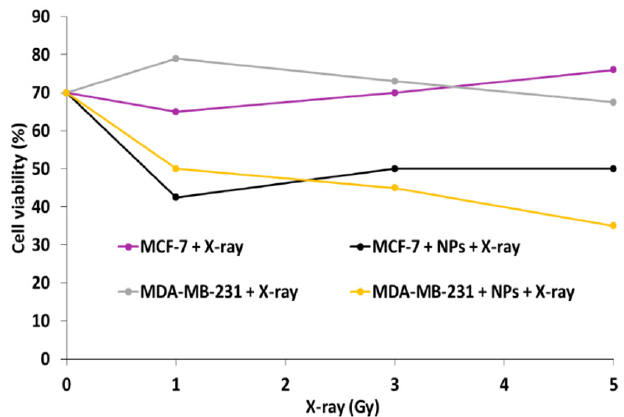
Figure 38. MDA-MB-231 and MCF-7 cells incubated (50 µg/mL) with core − shell − shell ScNP-PAH- RB-PEG-FA (NPs) for 24 h followed by X-ray radiation with doses of 1, 3, 5 Gy of. Adapted from Hsu et al. [105].